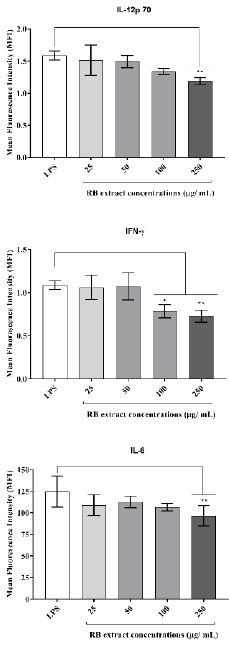
Figure 5. The effect of RB phenolic extracts in modulating pro-inflammatory cytokines. A significant reduction in IL-12p70 and IL-6 cytokines is observed after treatment with 250 µg/mL ( p < 0.01). Furthermore, the pre-treatment with 100 µg/mL ( p < 0.05) and 250 µg/mL ( p < 0.01) of the RB phenolic extract is observed to have resulted in a significant reduction in the IFN- γ cytokine compared to the control ( n = 5). The level of significance is indicated by the asterisks, whereby * p < 0.05, ** p < 0.01. Data are presented as mean ± SD. Lipopolysaccharide, LPS; rice bran,